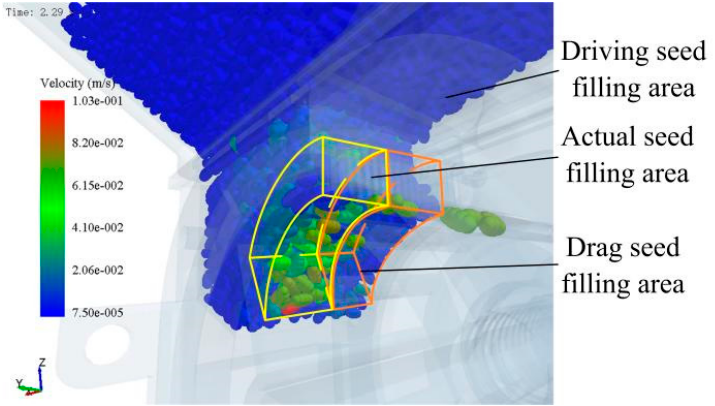
Figure 8. The division of the seed filling chamber of the seed metering